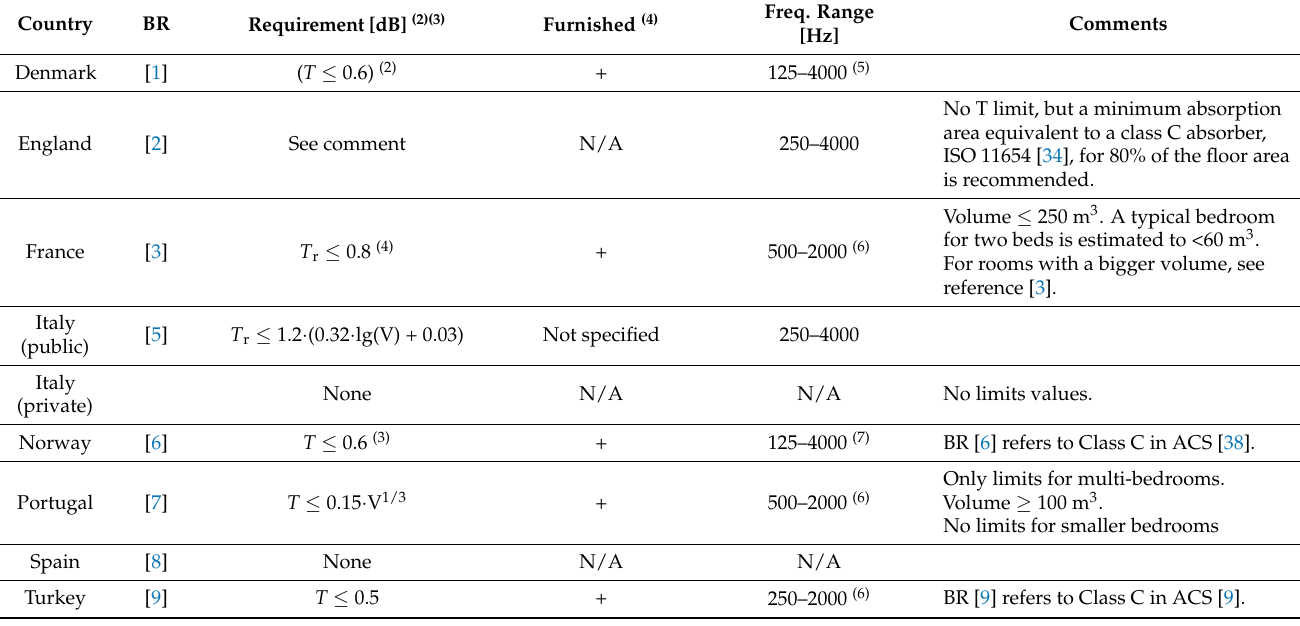
Table 6. Acoustic regulations for hospital bedrooms (1) —Reverberation time. November